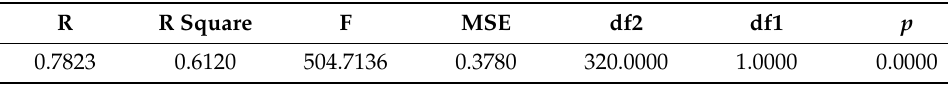
Table 11. Model Summary (path-a).